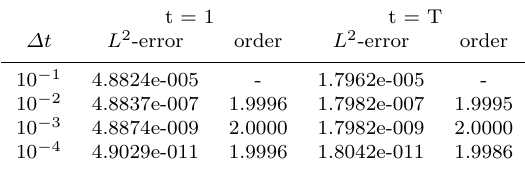
Table 3. Temporal convergence rates at t = 1 and t = 2 for Example 1. t = 1 t = T ∆t L 2 -error order L 2 -error order 10 − 1 4.8824e-005 - 1.7962e-005 - 10 − 2 4.8837e-007 1.9996 1.7982e-007 1.9995 10 − 3 4.8874e-009 2.0000 1.7982e-009 2.0000 10 − 4 4.9029e-011